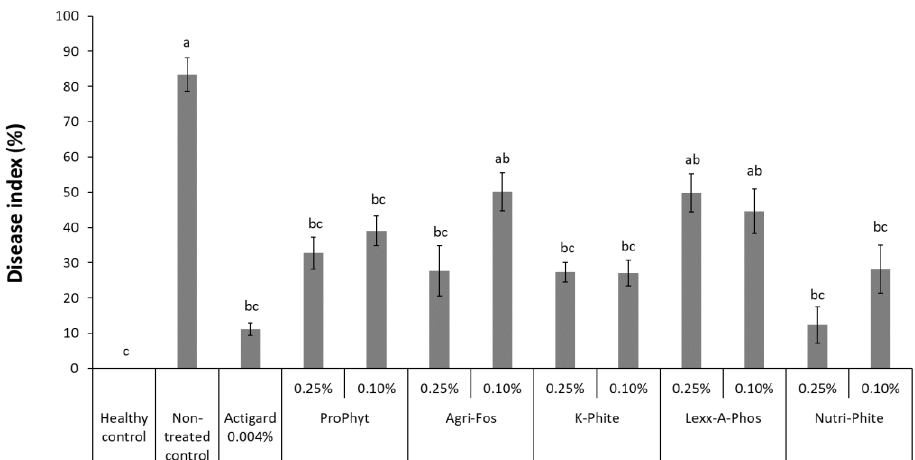
Figure 2. Severity of Phytophthora blight of pepper plants (cv. Camelot) under different treatments. Data are the mean of four replicates ± standard deviation. Values accompanied by the same letters are not significantly different according to Fisher’s least significant difference test ( p = 0.05).